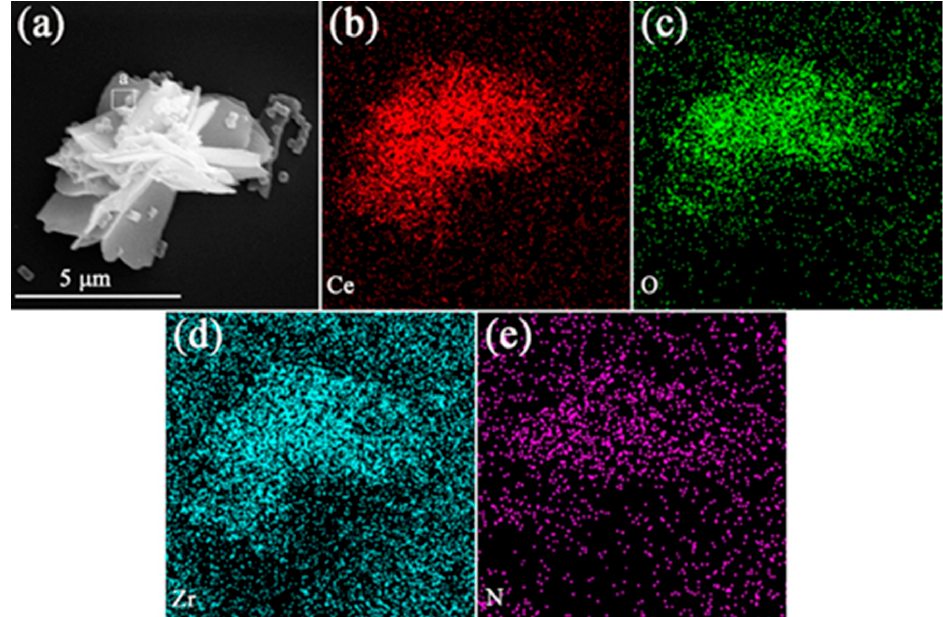
Figure 9. Elements maps analysis of 400 °C 1-Ce/UN composites: ( a ) SEM image; ( b – e ) element analysis of Ce, O, Zr and N. Table 1. The EDS results of the area “a” signed in Figure 9a.